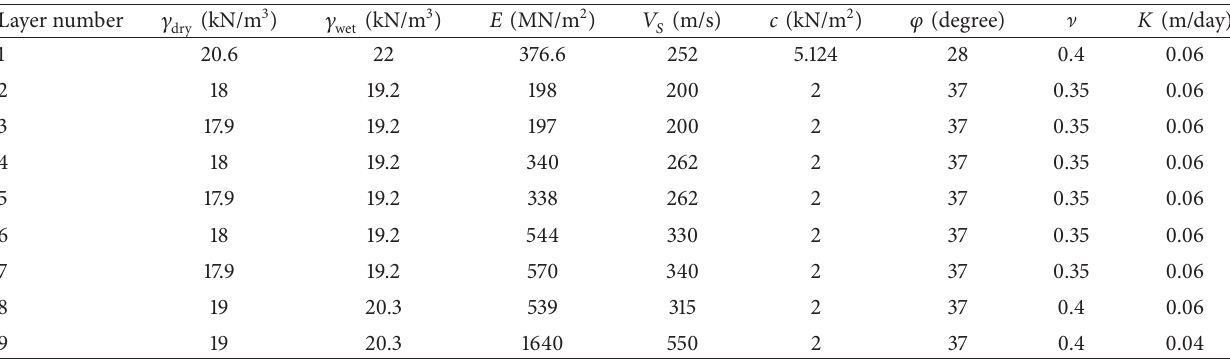
Table 2: Soil properties of the Upper San Fernando dam.